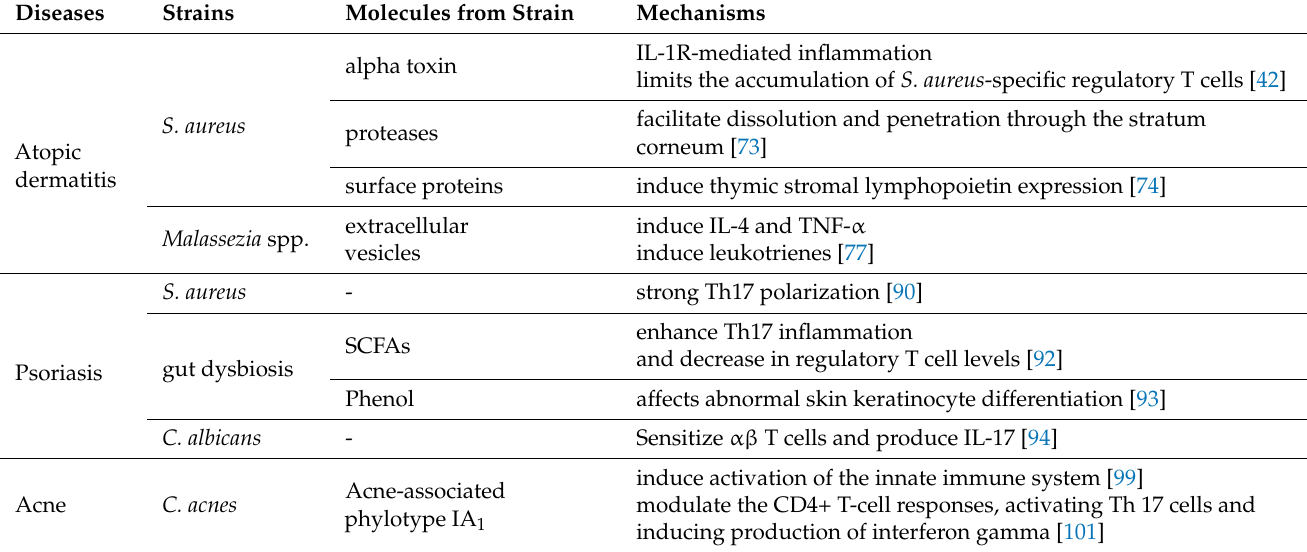
Table 1. Inflammatory skin disorders and